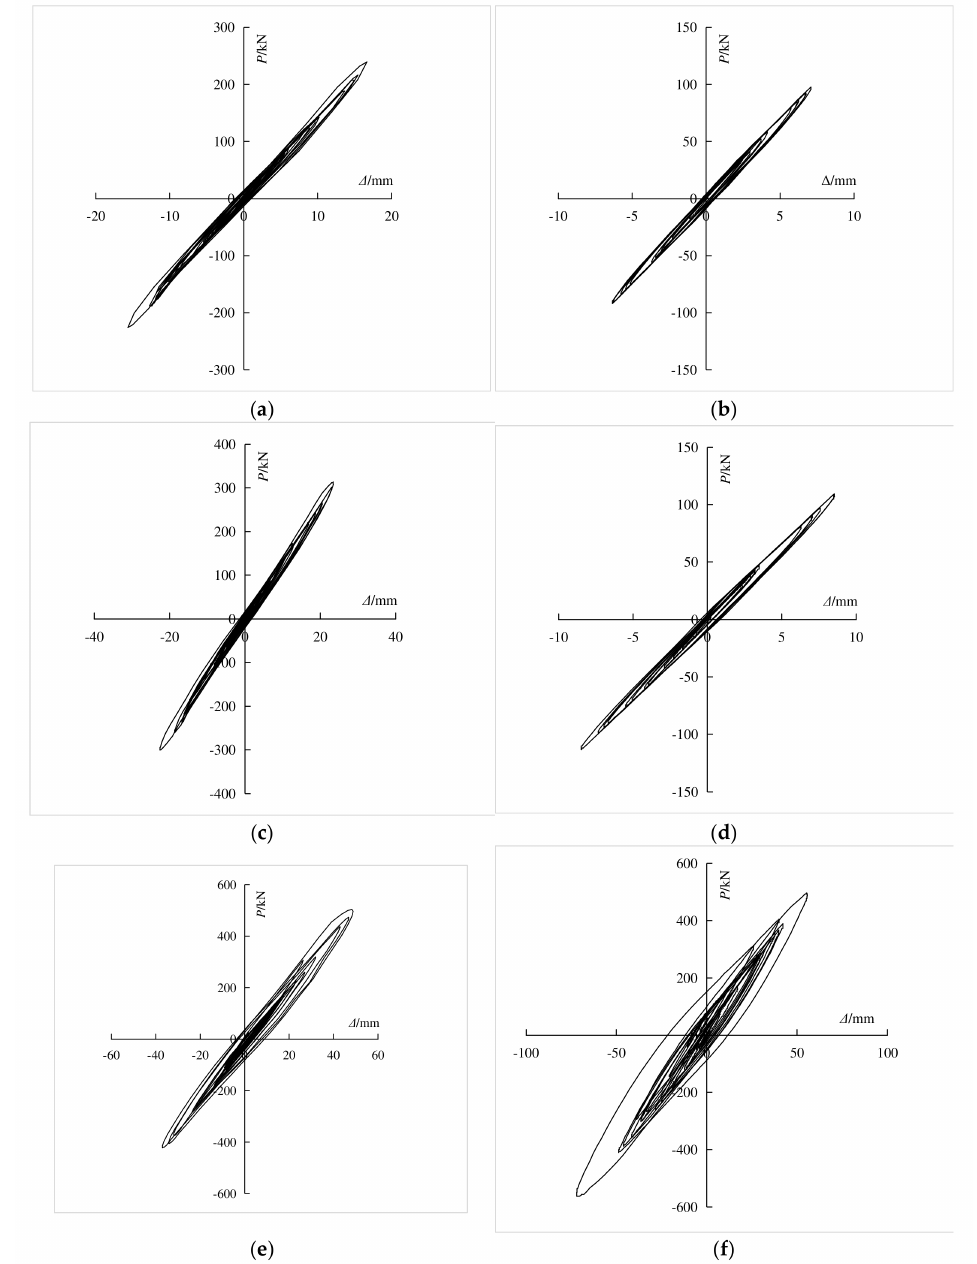
Figure 12. Hysteretic curve of base shear-top displacement. ( a ) 70 gal El Centro wave; ( b ) 70 gal Lanzhou wave; ( c ) 100 gal El Centro wave; ( d ) 100 gal Lanzhou wave; ( e ) 200 gal El Centro wave; ( f ) 400 gal Lanzhou